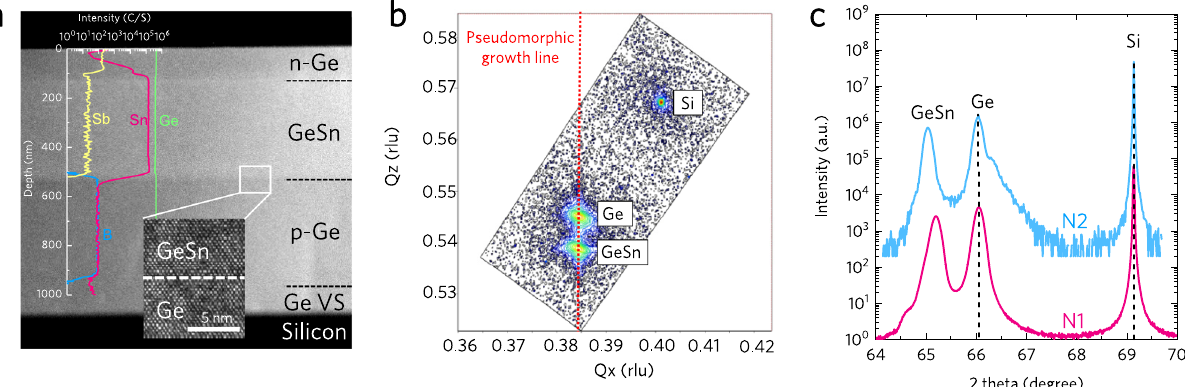
Fig. 1 Material characterization of the grown samples. a Cross-sectional transmission electron microscopic (XTEM) image of sample N1 overlapped with secondary ion mass spectrometry (SIMS) atomic distribution. Inset: a high-resolution XTEM image of the Ge/GeSn interface, revealing pseudomorphic growth. b (224) reciprocal space mapping (RSM) of sample N1, showing pseudomorphic GeSn/Ge heterostructures. c ω – 2 θ scans of samples N1 (red line) and N2 (blue line), showing shifted GeSn peaks with increasing Sn